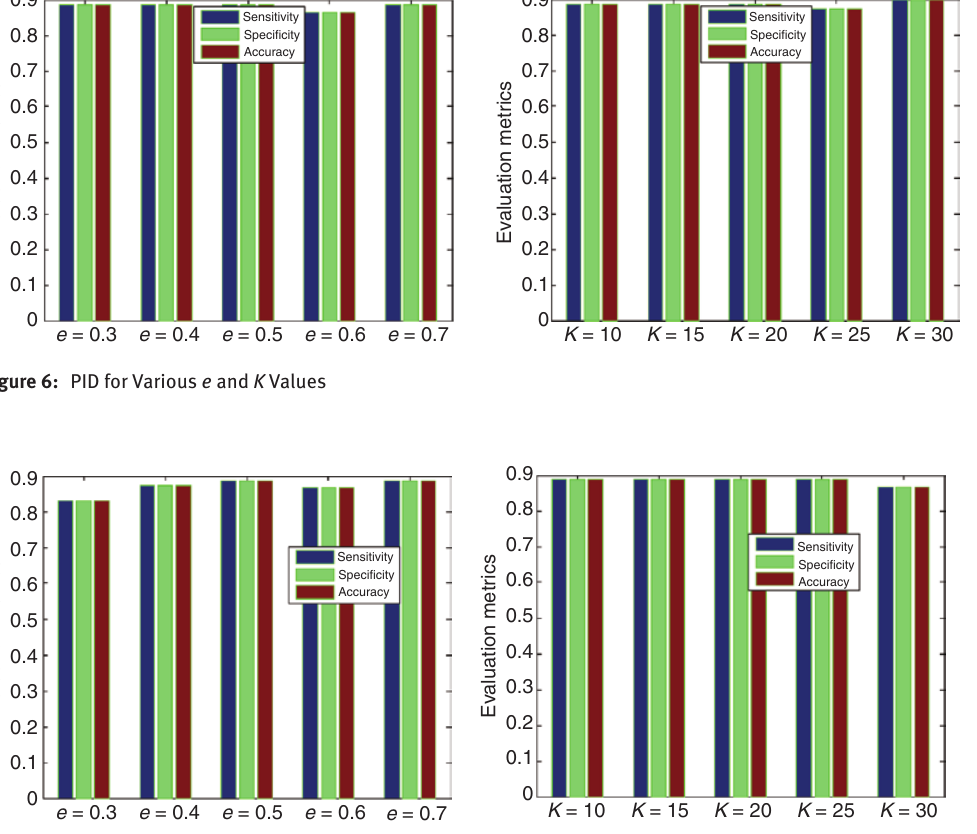
Figure 7: Cleveland for Various e and K